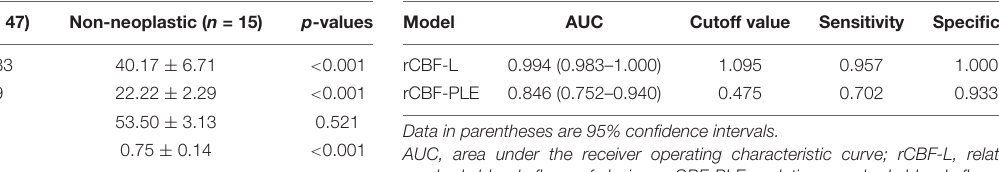
TABLE 3 | Diagnostic performance of rCBF-L and rCBF-PLE for differentiating non-neoplastic from neoplastic lesions.